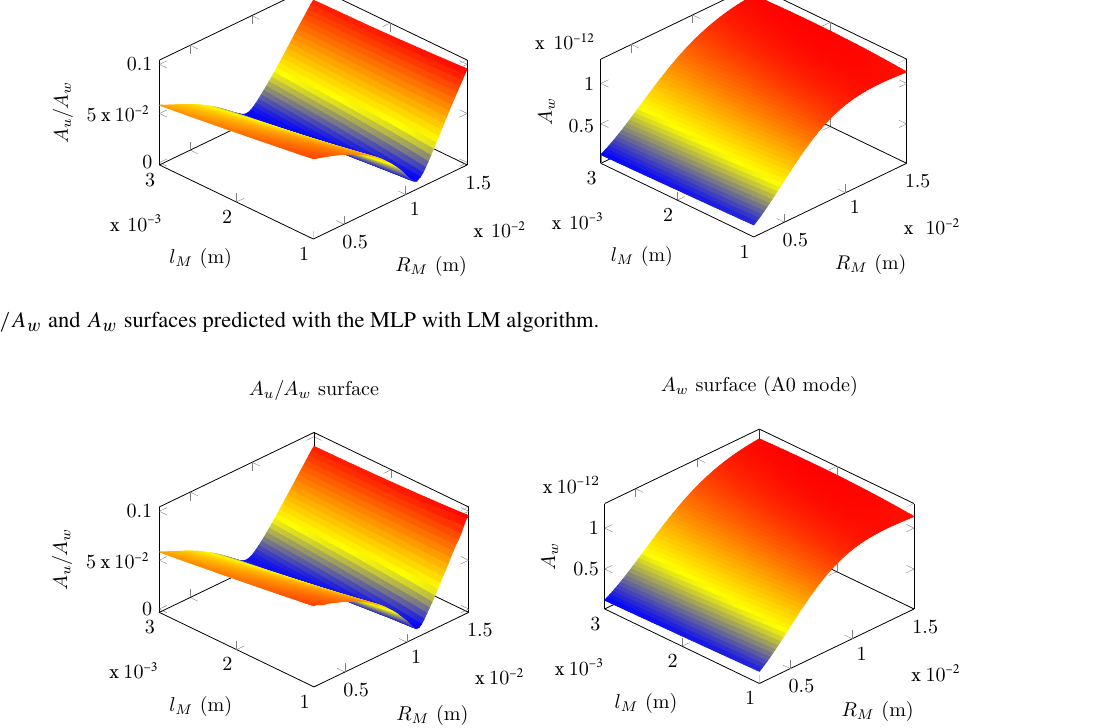
Figure 10. A u /A w and A w surfaces predicted with the RBFNN with exact interpolation.